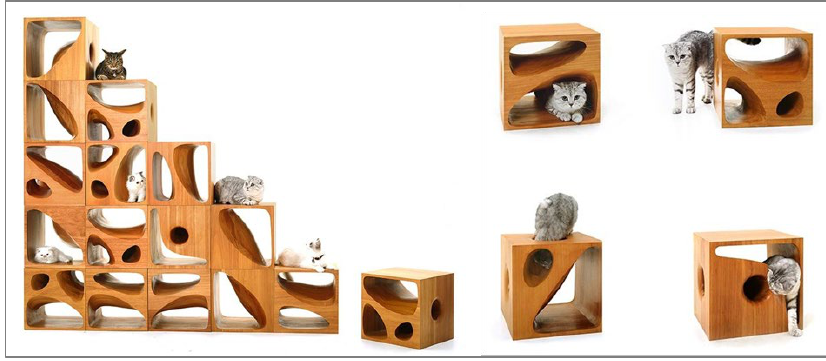
Figure 10 LYCS Architecture’s design “CATable 2.0”